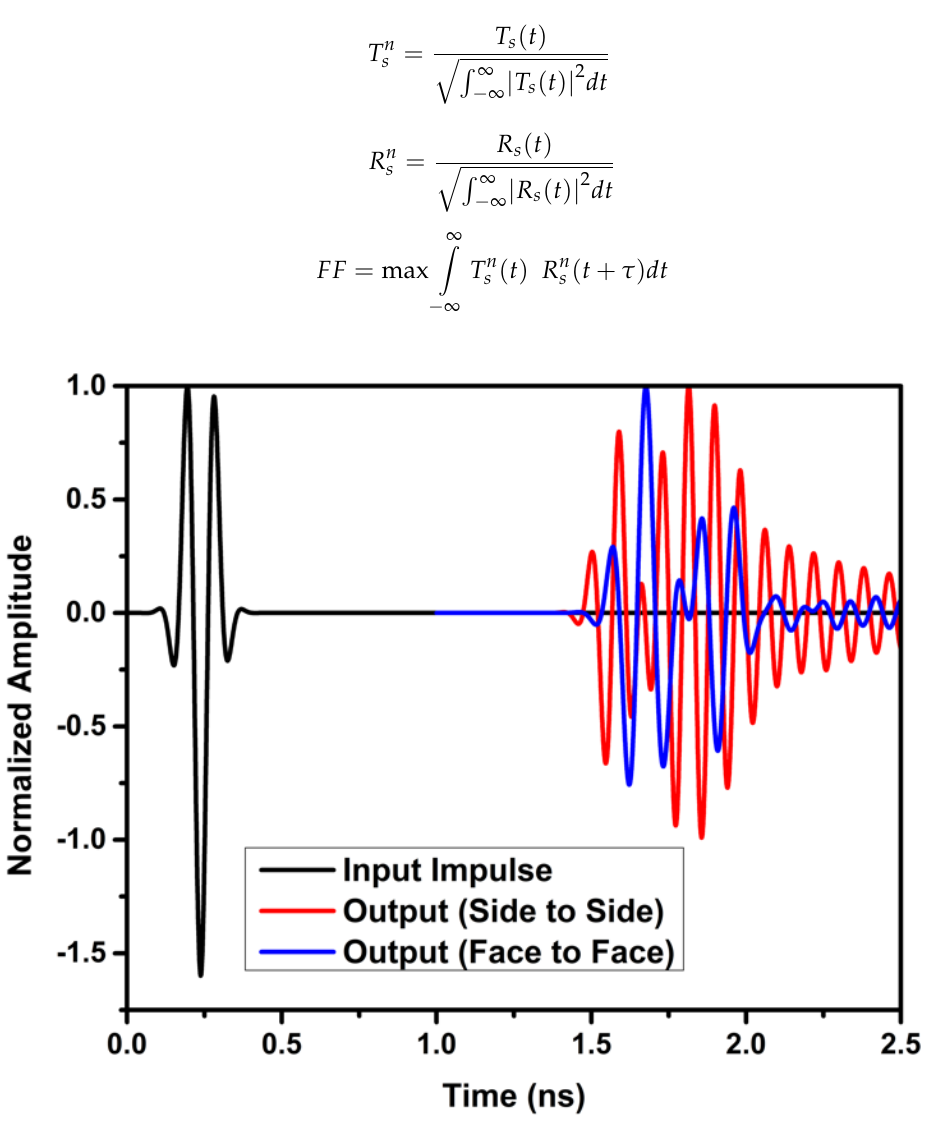
Figure 17. Fidelity factor.